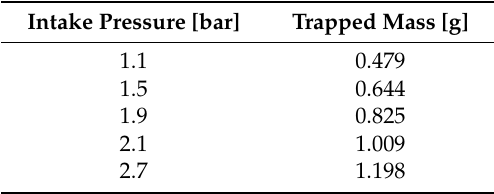
Figure 12. Maximum cylinder pressure ( left ) and air mass flow ( right ) for each tested condition. Table 4. The in-cylinder trapped mass estimated for each tested engine